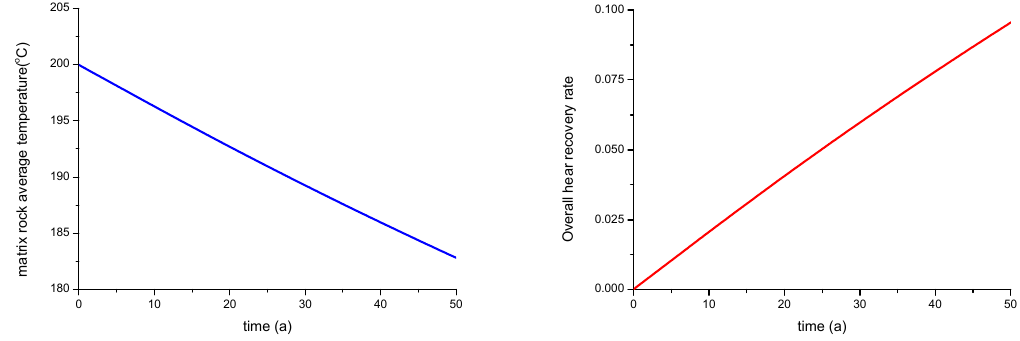
Figure 9. Evolution of overall heat recovery rate and matrix rock average temperature.